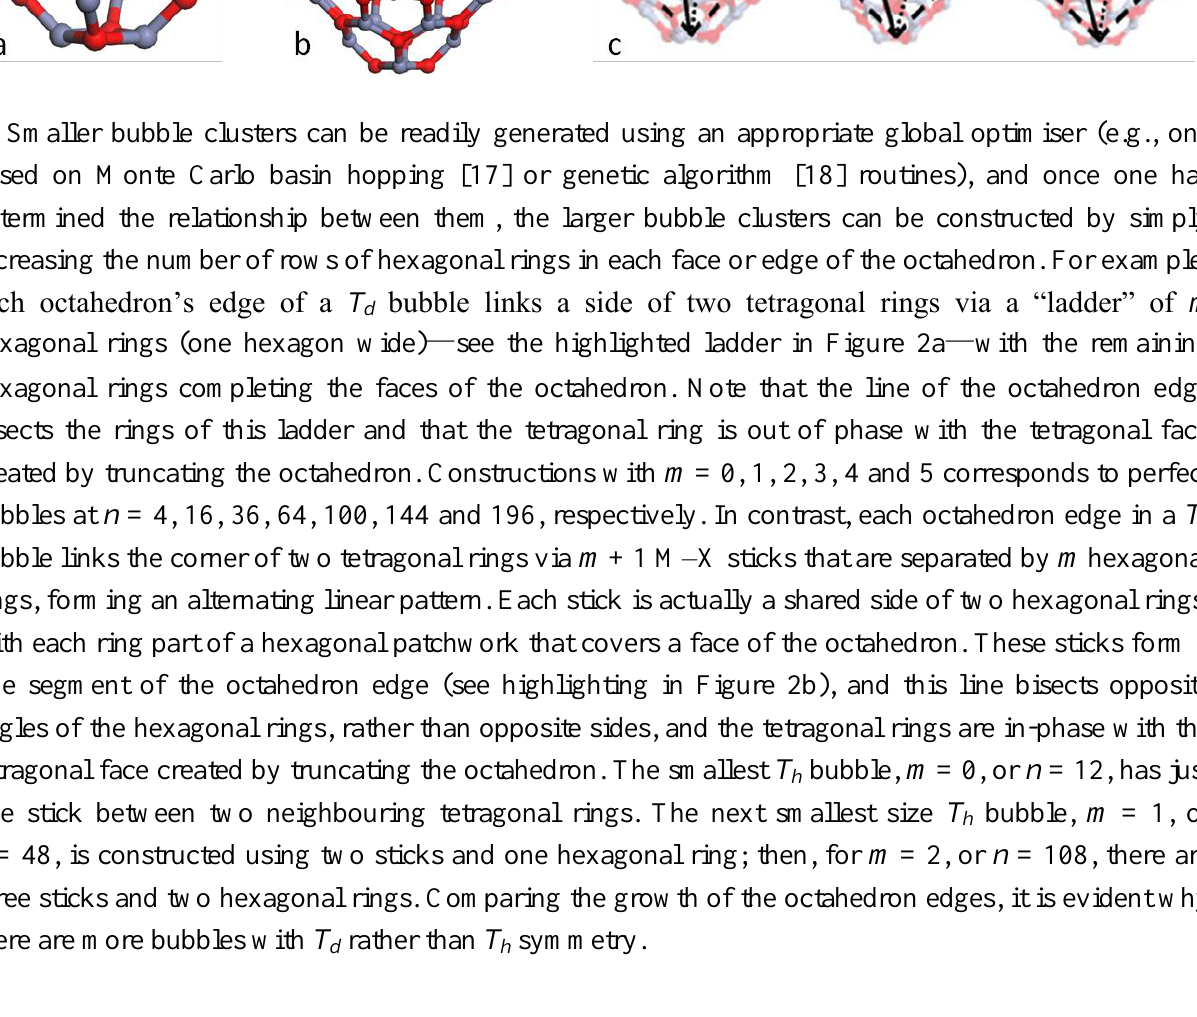
Figure 1. Models of high symmetry (MX) ( b ) n = 48 with symmetry T